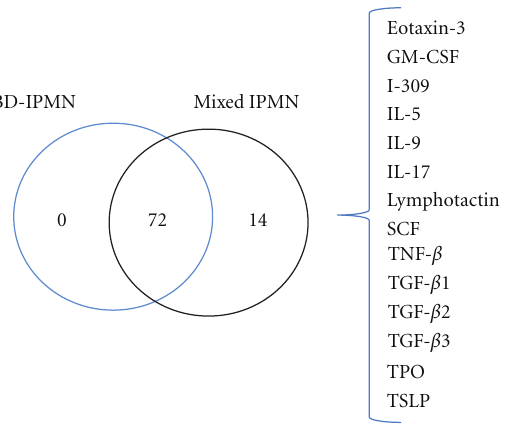
Figure 2: Venn diagram of IMPs identified in BD-IPMN and mixed IPMN. IMPs detected only in mixed IPMN are listed to the right of the diagram. Of the 89 IMPs assayed, three were not detected in either types of cyst (b-NGF, IL-11 and